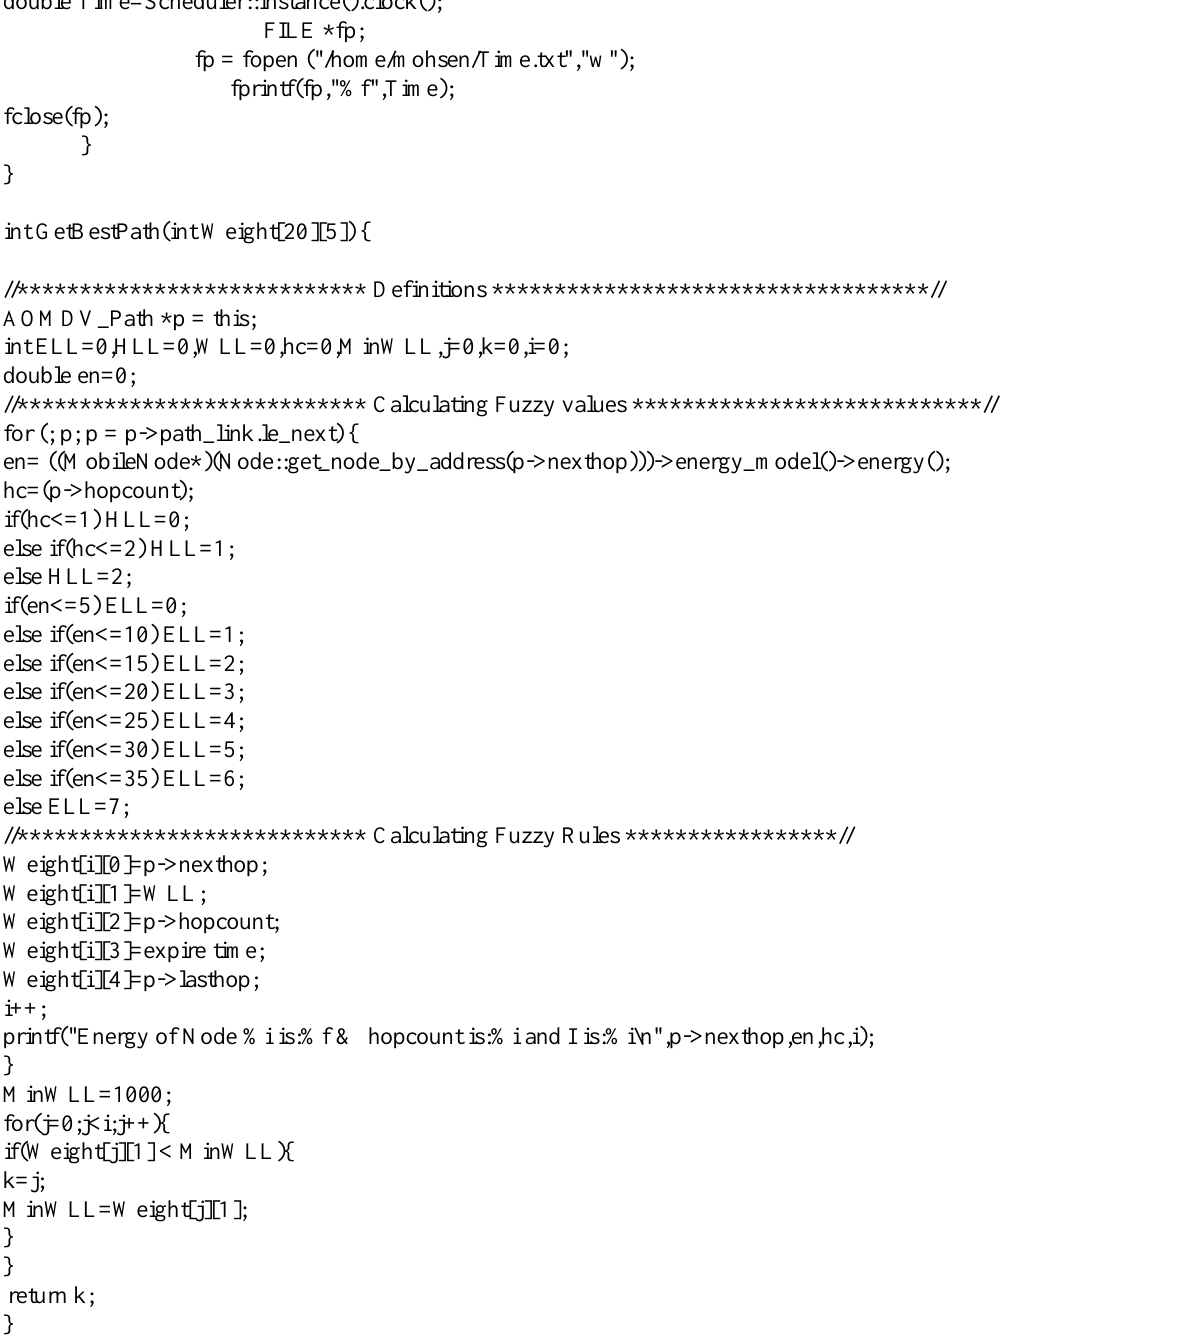
Fig. 2. The head file of proposed protocol